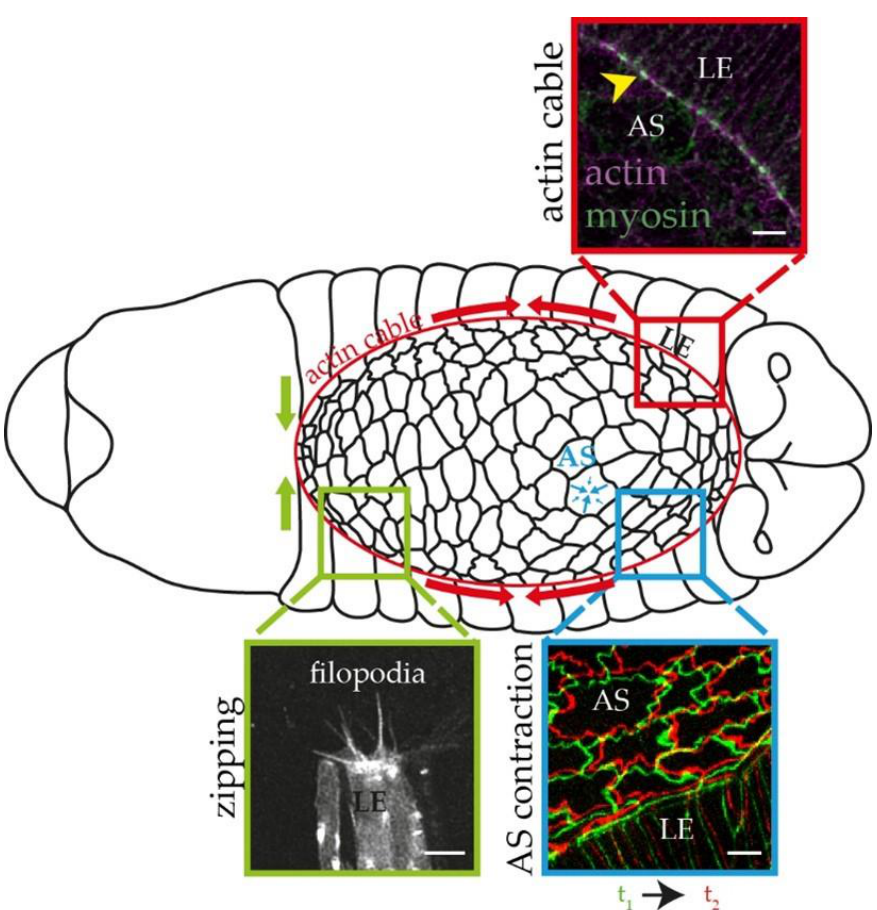
Figure 1. Schematic drawing of the process of dorsal closure in Drosophila embryos. Red arrows indicate the contraction of the actin cable around the dorsal gap. Red magnified region: a w 1118 embryo stained for actin (in magenta) and non-muscle Myosin II (in green) in the LE and the AS cells. Note that the actin and myosin stainings co-localize at the actin cable (arrowhead). Green arrows indicate the zipping forces at the LE cells. Green magnified region: LE cells from a single hemisegment of an en-Gal4, UAS-Moe::mCherry embryo, exhibiting filopodia. Blue arrows indicate the contraction of the AS cells. Blue magnified region: AS cells from an Arm::GFP-expressing embryo, indicating the displacement of the cell boundaries at two timepoints (t1 and t2) of the contraction. Scale bars: 5 µ